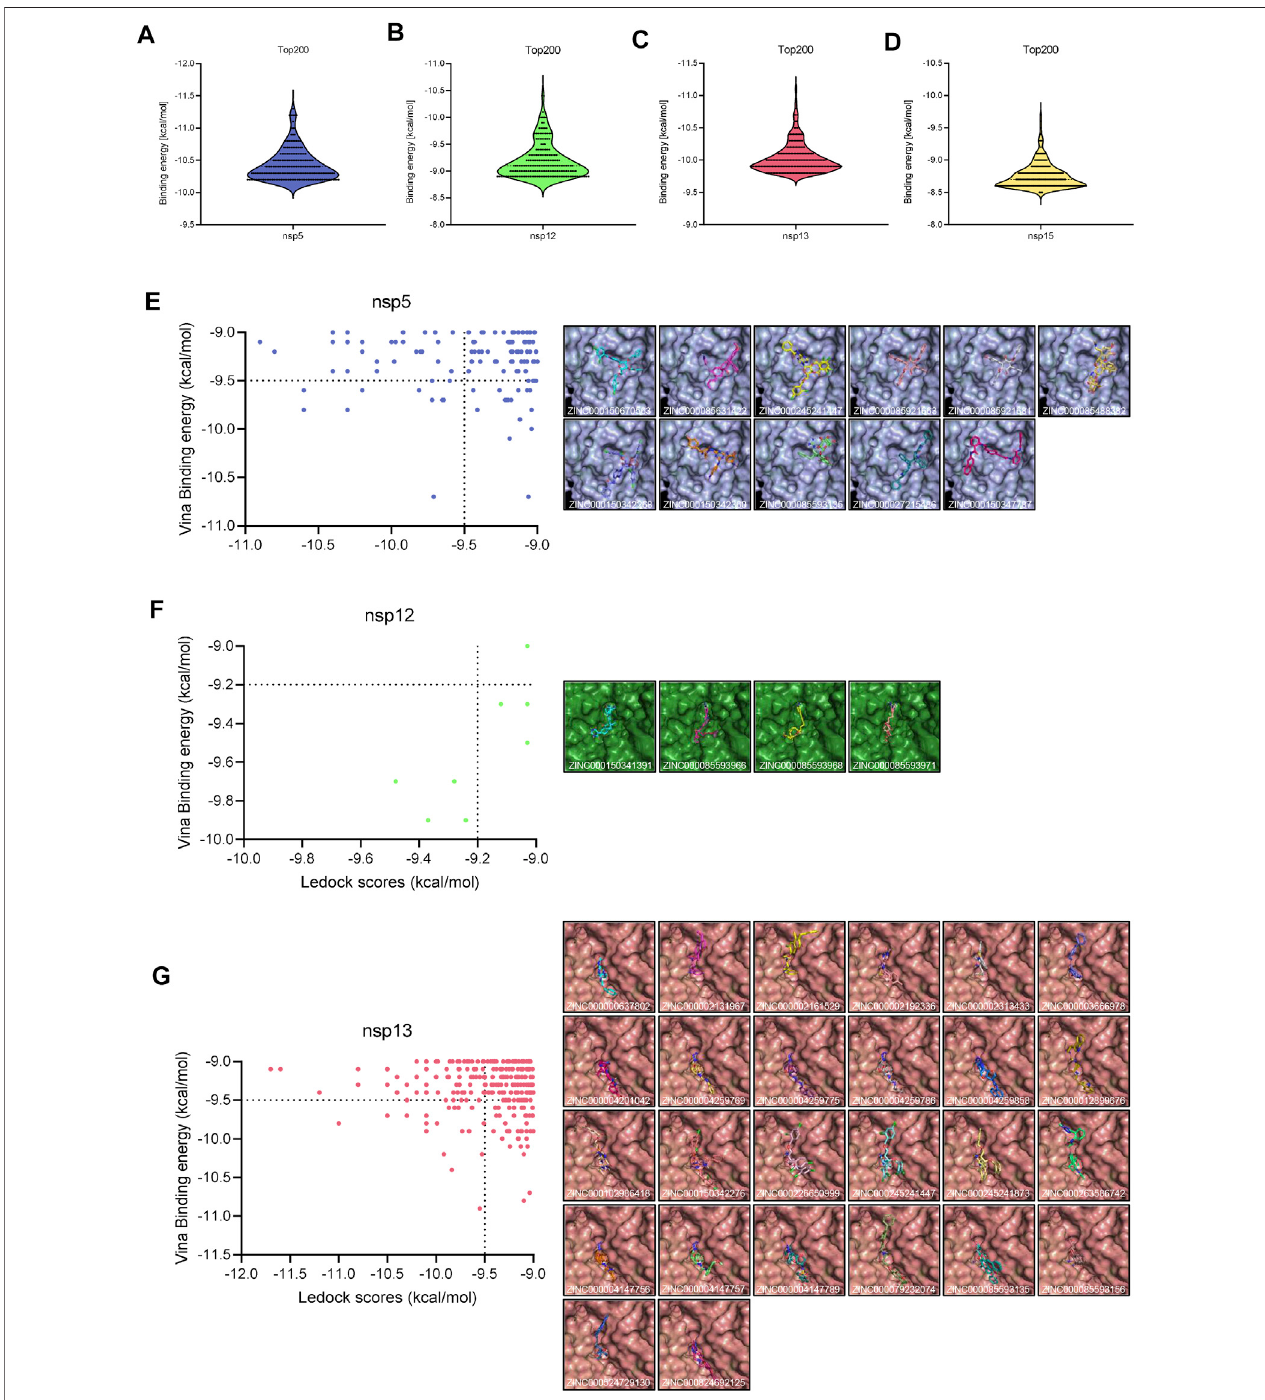
FIGURE1| Virtualscreening. (A – C) Distributionofthedockingscoresofthetop200virtualscreeninghitsbyAutoDockVina. (E – G) Left:distributionofhighbinding energy hits by LeDock; right: overview of the interactions between the ligand and the receptor structure.